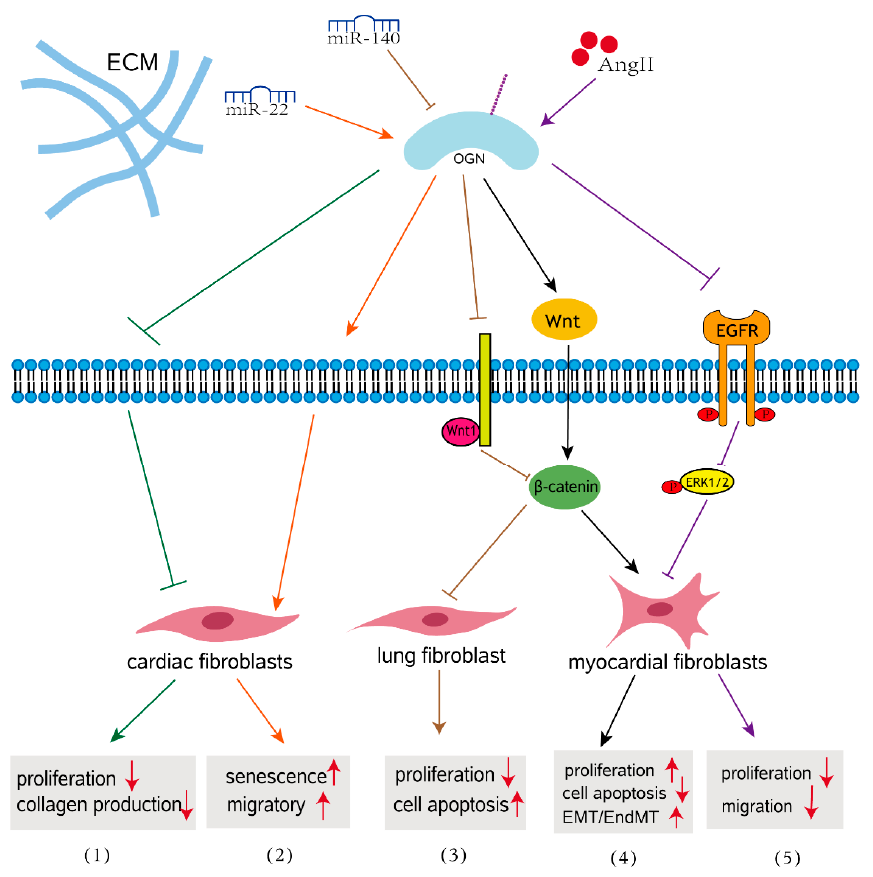
Figure 2. OGN signaling in fibrosis. (1) OGN reduces cardiac fibroblast proliferation and TGF β - mediated collagen production in age-related hearts. (2) MiR-22 overexpression induced cellular senescence and promoted the migratory activity of cardiac fibroblasts by targeting OGN in the aging heart. (3) Overexpressed miR-140 inhibits pulmonary fibrosis in interstitial lung disease via the Wnt signaling pathway by downregulating OGN. (4) OGN enhances myocardial fibrosis and reverses EMT/EndMT in a mouse model of myocarditis. (5) OGN regulates cardiac myofibroblast proliferation and migration in response to AngII by suppressing EGFR signaling.